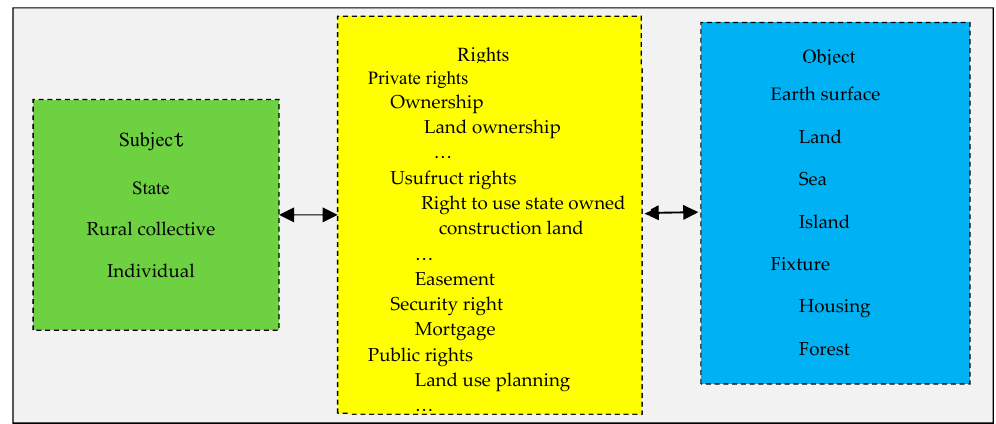
Figure 4. Property rights structure of China’s natural resources.